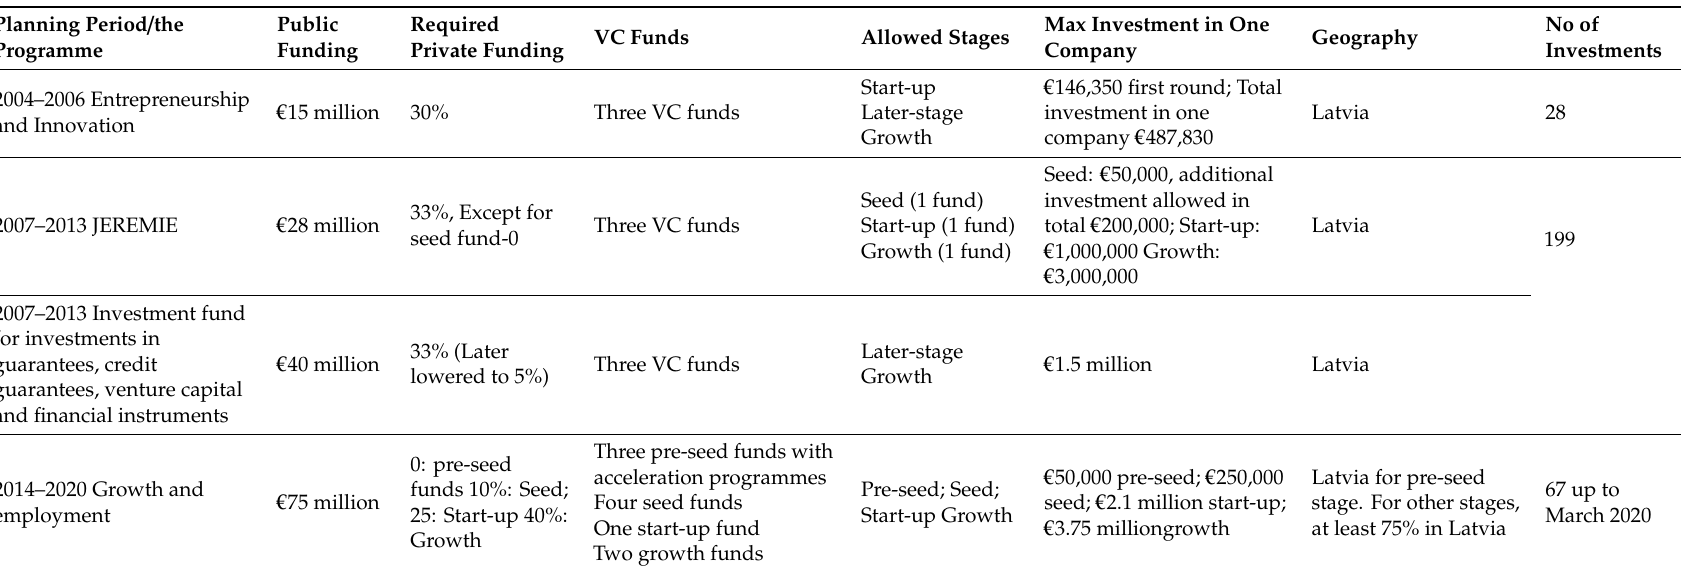
Table 2. Public VC interventions in Latvia.